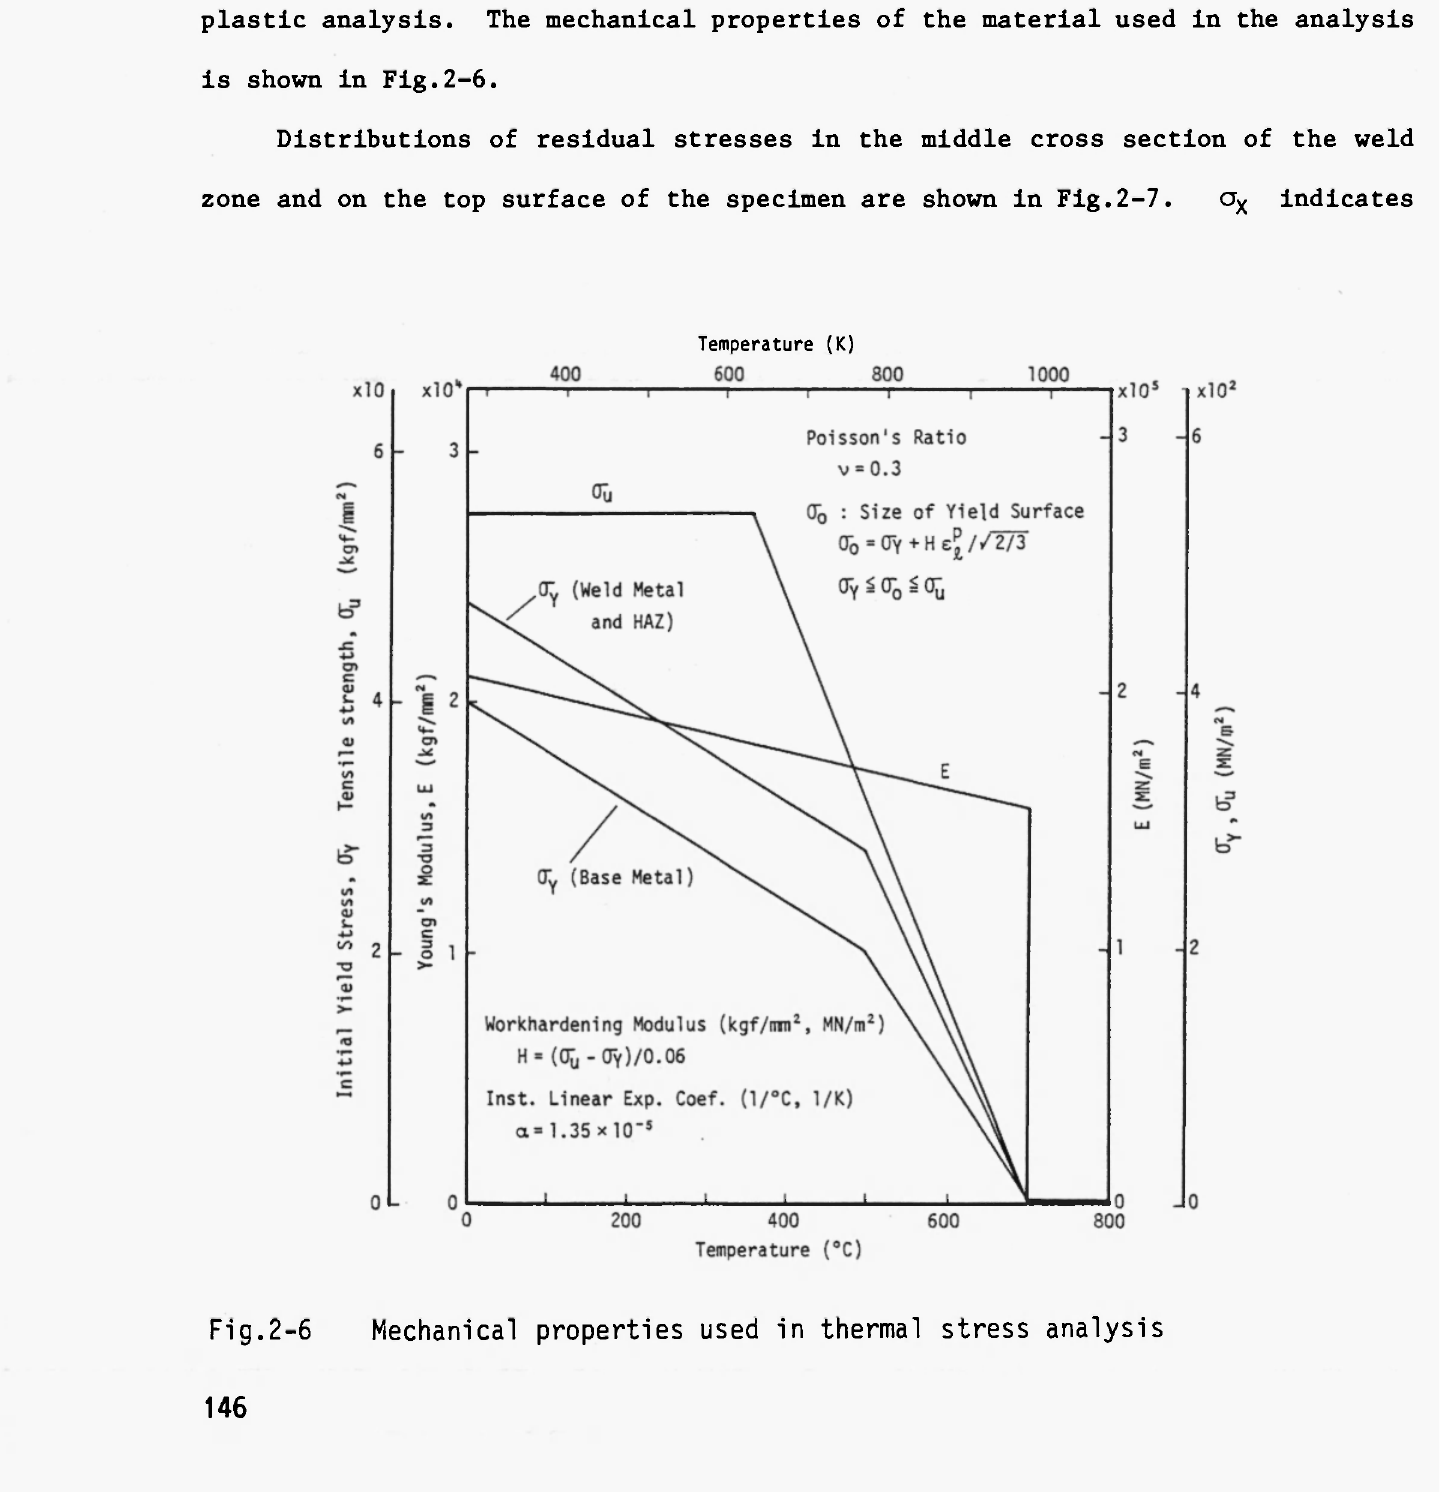
Fig.2-6 Mechanical properties used in thermal stress